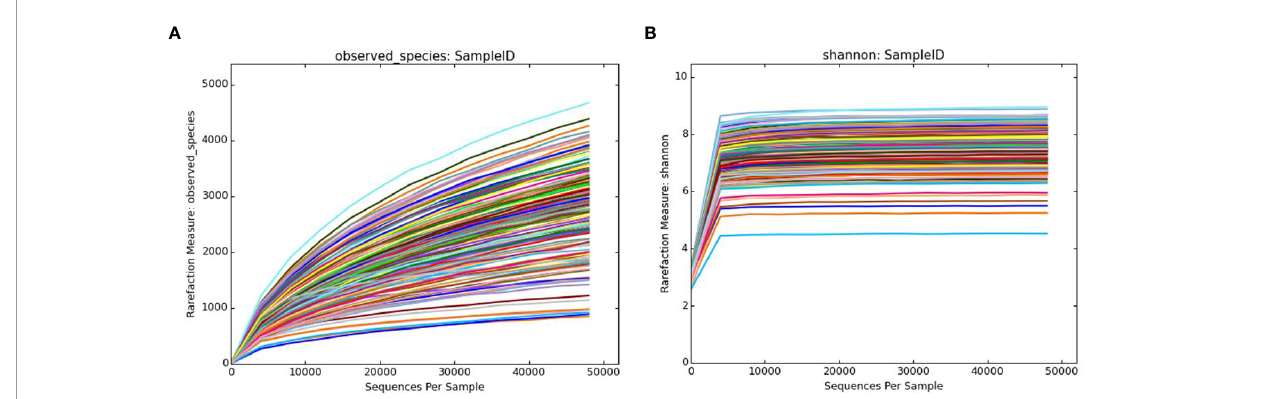
FIGURE 4 | Dilution curve and Shannon-Wiener curve. (A) The observed_species dilution curve. The observed_species index represents the actual number of OTUs observed. The x-axis represents the number of sequences randomly selected for each sample, and the y-axis represents the number of OTUs at the corresponding depth. (B) The Shannon-Wiener curve. The x-axis represents the number of randomly selected sequences, and the y-axis represents the Shannon index that re fl ects the species diversity. Each color in the fi gure represents a single sample. OTU, operational taxonomic unit.